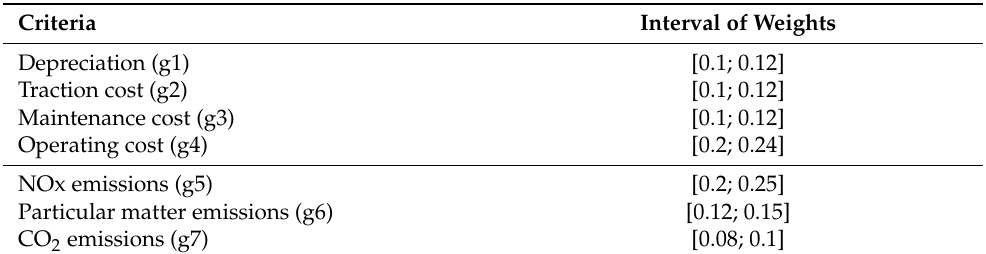
Table 19. Variation ranges of the criteria weights considering that economic criteria are as important as environmental criteria.